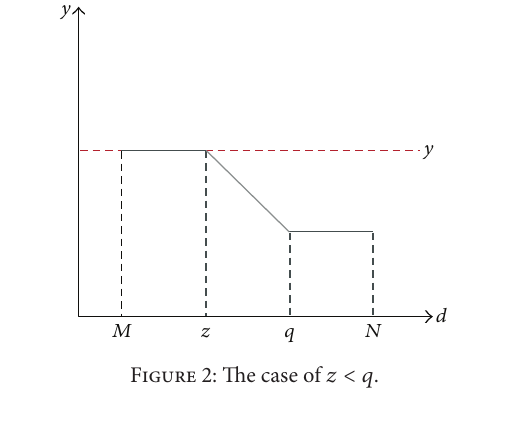
Figure 4: Impacts of 𝜎 on 𝑞 ∗ .